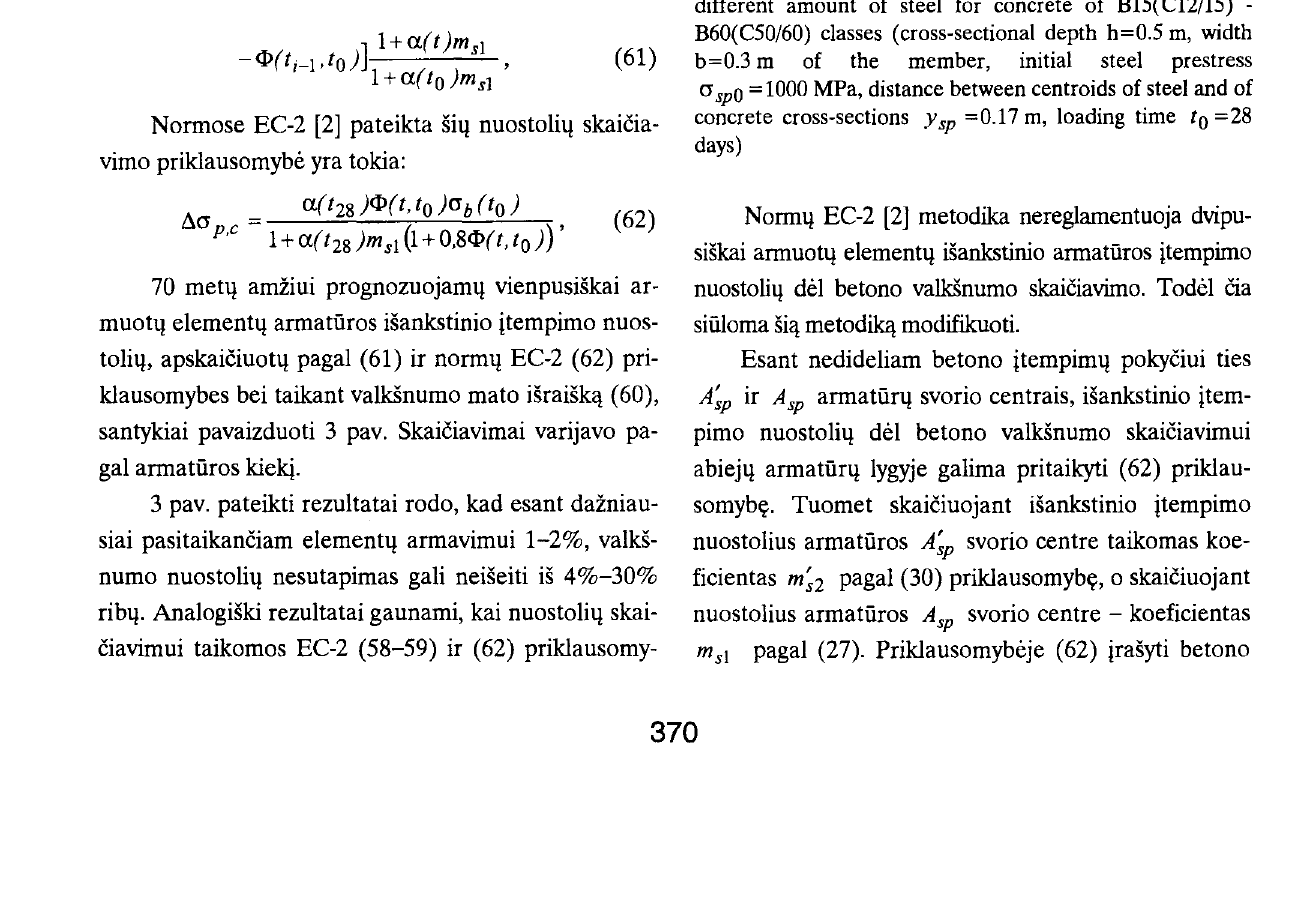
tro Ysp =0,17 m, apkrovimo laikas to =28 paros) Fig 3. Ratio between steel prestress losses due to creep in a member with steel in one side determined by the method of analysis proposed acp and that of EC-2 Code [2] ncr pc at different amount of steel for concrete of B15(C12/15) - B60(C50/60) classes (cross-sectional depth h=0.5 m, width b=0.3 m the initial steel prestress cr spO = 1000 MPa, distance between centroids of steel and of concrete cross-sections y sp =0.17 m, loading time to =28 days)